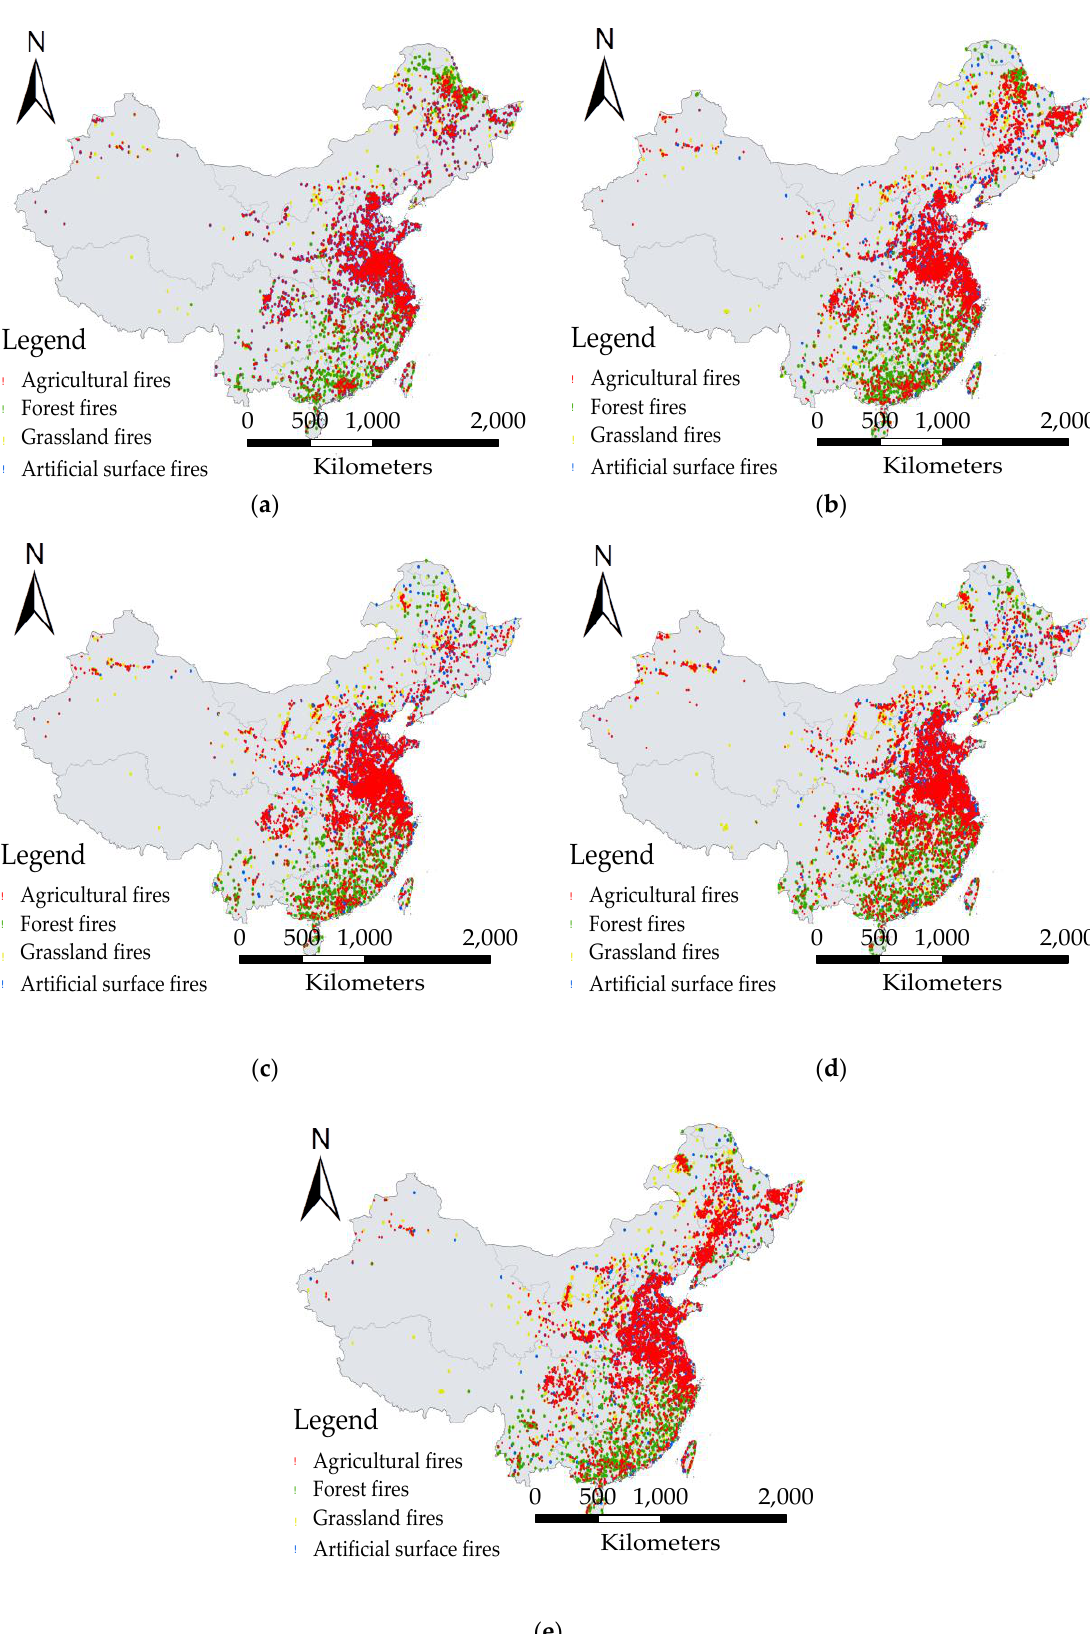
Figure 4. Spatial distribution of the main fires detected in China from 2010 to 2014: ( a ) 2010; ( b ) 2011; ( c ) 2012; ( d ) 2013; ( e ) 2014.